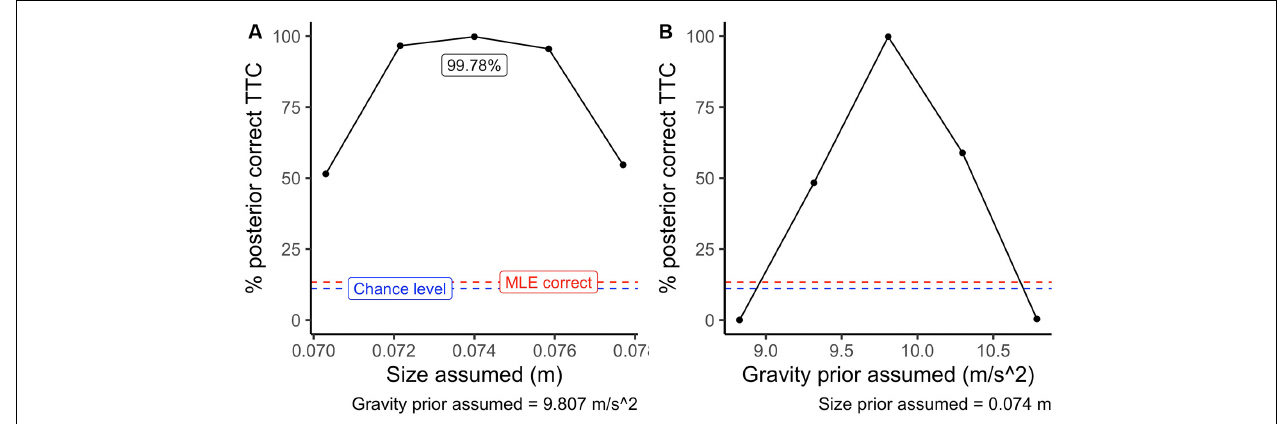
FIGURE 6 | Average accuracy per procedure. The blue dashed line indicates chance level (11.1%), red dashed line indicates the performance of an maximum likelihood estimate (MLE) procedure. The black points indicate the performance assuming different size priors in panel (A) ( g = 9.807 m/s 2 assumed) and assuming different gravity priors in panel (B) (baseball size assumed).